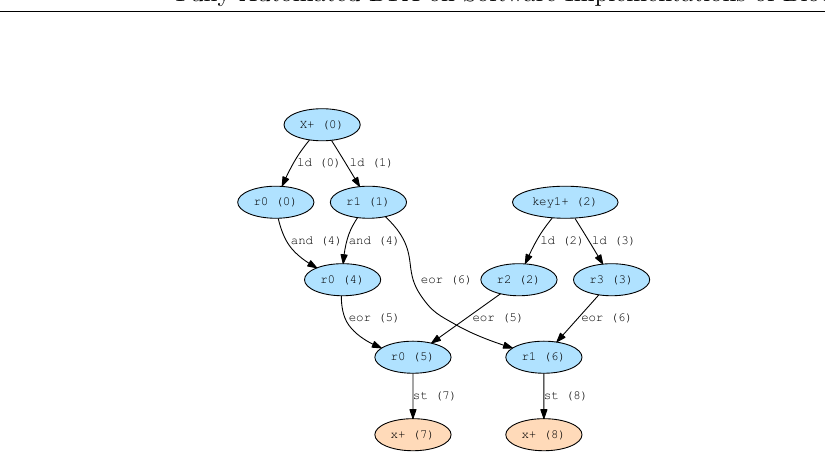
Figure 5: Updated graph generated by TADA after two successful attacks on vulnerable instruction 4 of example cipher F ex in Table